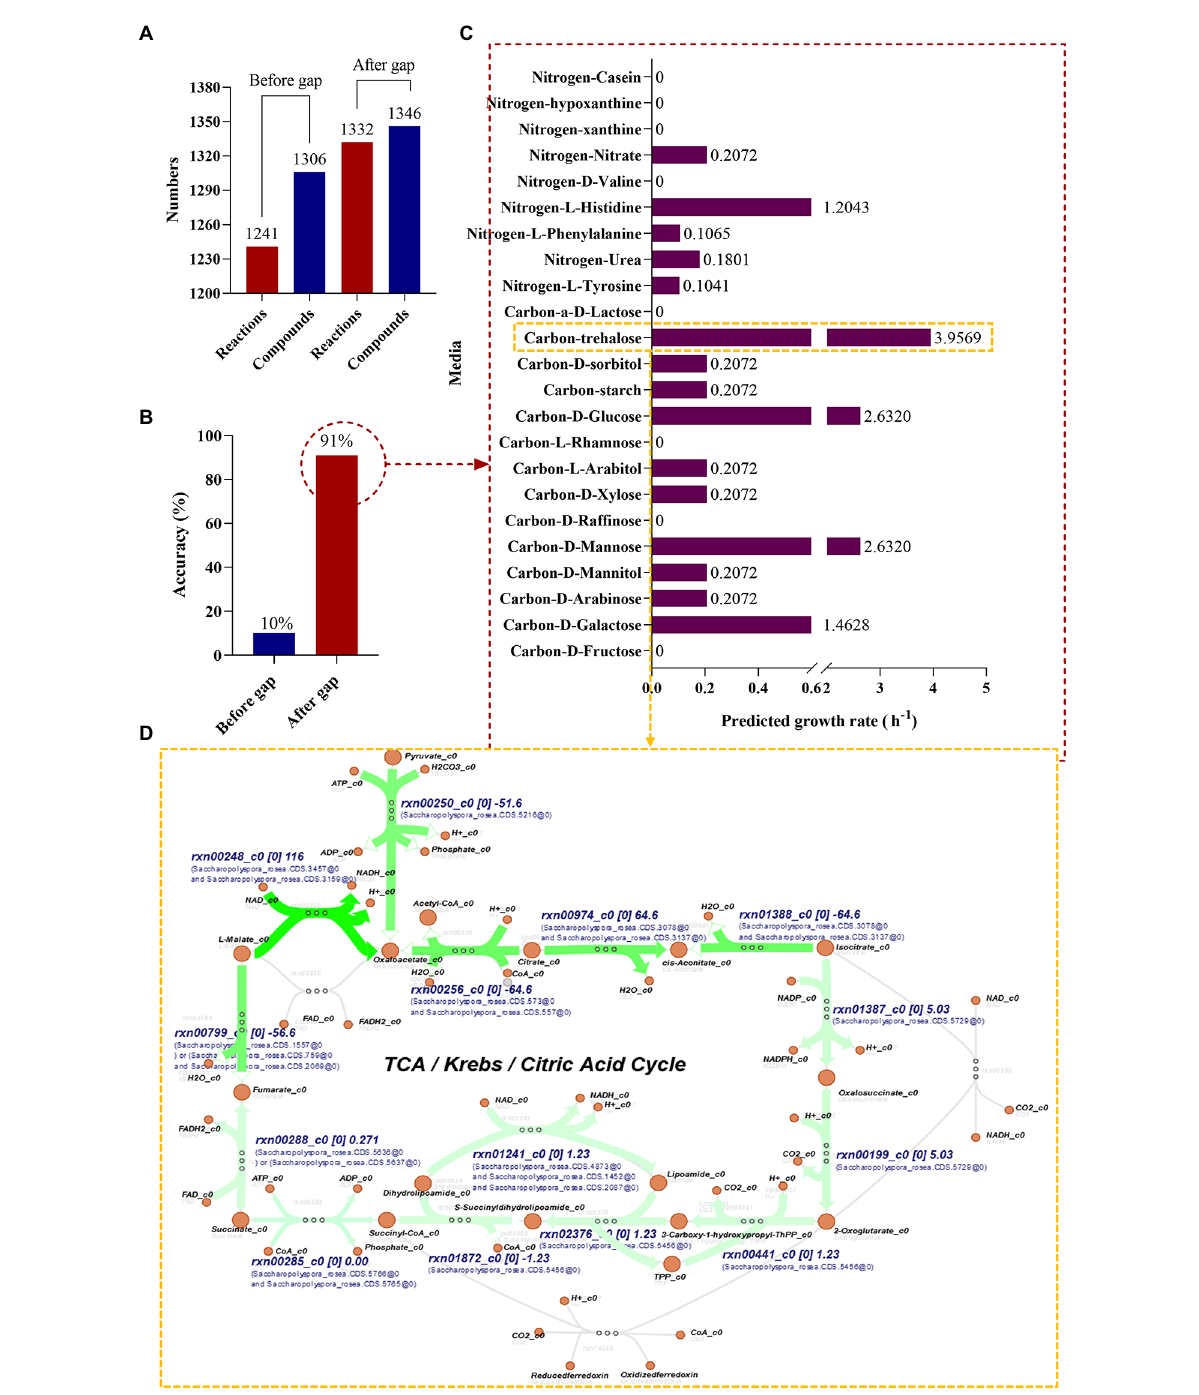
FIGURE 5 Genome-scale metabolic model construction and growth prediction of S. rosea A22 in different media. (A) Number of reactions and compounds included in the model. (B) The accuracy of prediction based on phenotypic data. (C) Flow balance analysis on different media. (D) Visualization of flux distribution of trehalose as a carbon source in the TCA cycle